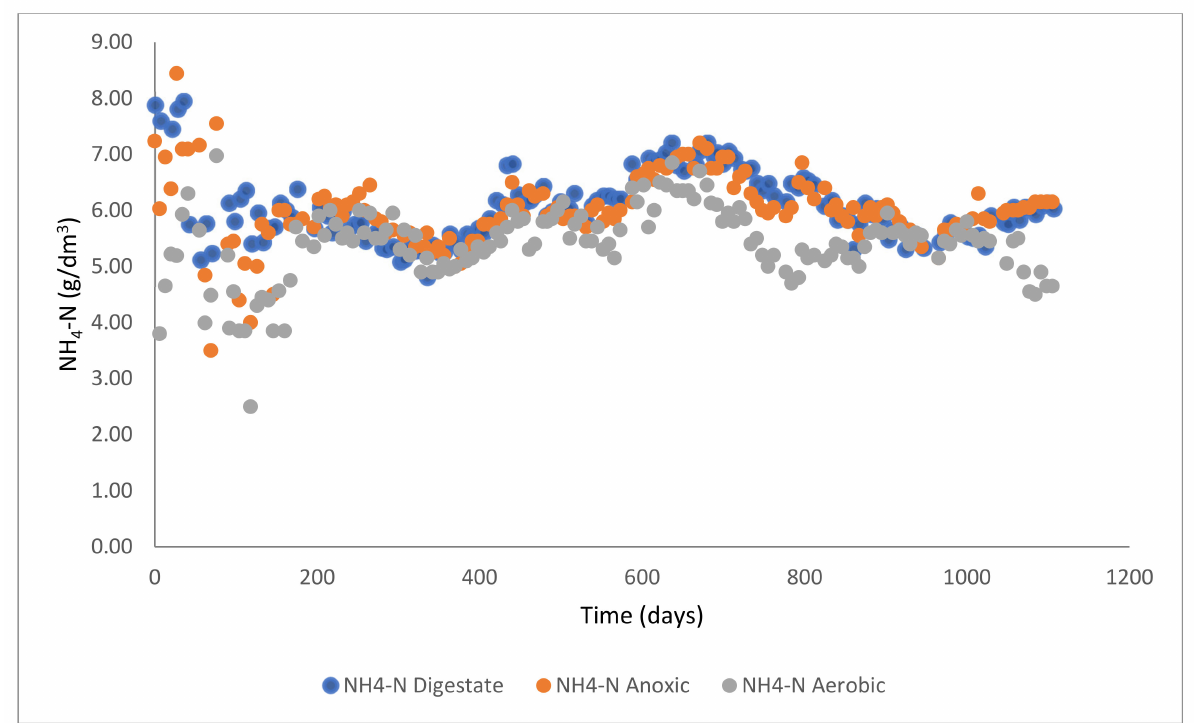
Figure 5. Total Nitrogen concentration monitored during each stage of the pilot plant.